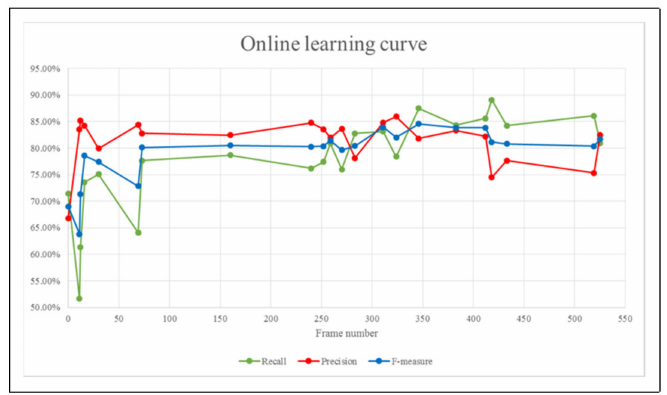
Figure 27. Online learning curve.